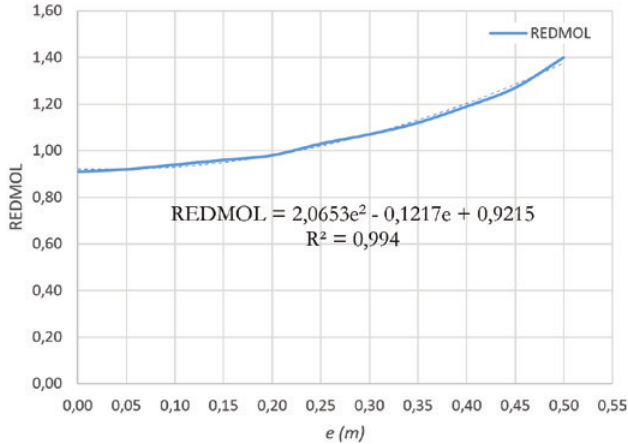
obtidos para o modelo z